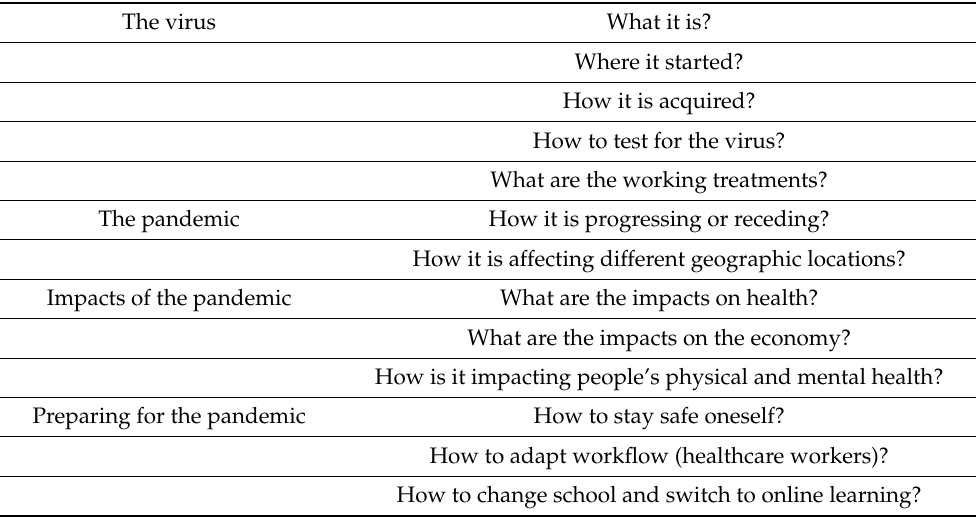
Table A2. Types of information